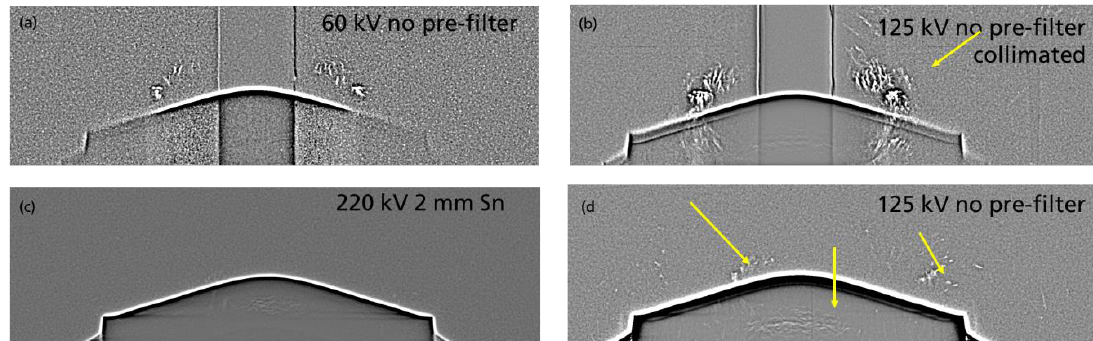
Figure 9. Brag diffraction patterns superposing the 2D projection images acquired by averaging images from 360°. The different images were acquired at different X-ray energies. The images have been filtered using a bandpass filter. Images ( a ) and ( b ) were obtained using a vertical lead slit for collimation. This approach allows a better detection capability of the peaks. Without collimation some of the signals are superposed by the unattenuated X-ray intensity as can be seen comparing (b) and ( d ). The cut-off of the low energies applied in ( c ) confirms that diffraction is induced at low energies.